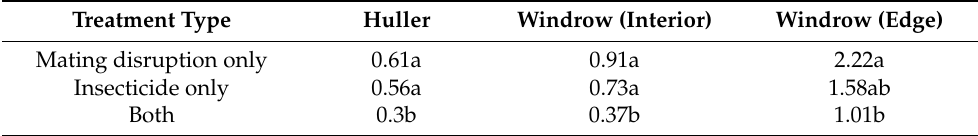
Table 1. Median damage (percent) of all almond varieties by treatment type over 10 years.